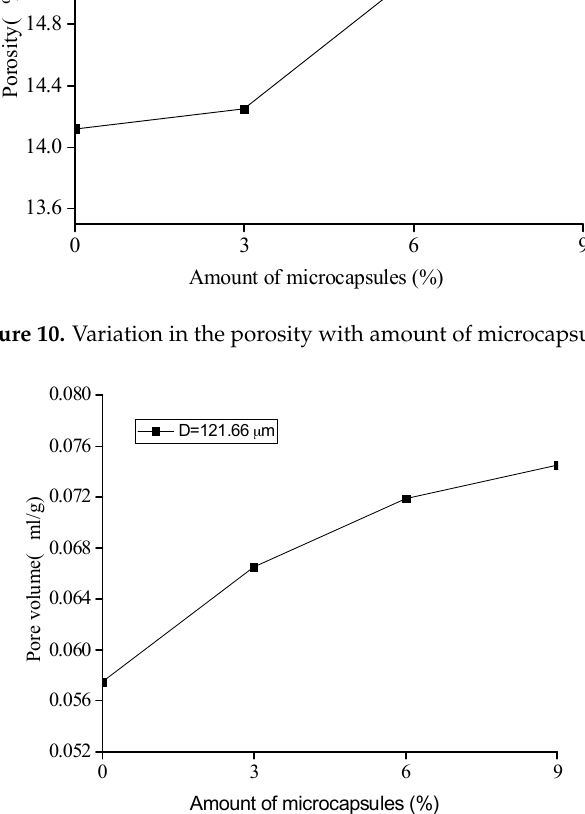
Figure 11. Variation in the pore volume with amount of microcapsules.